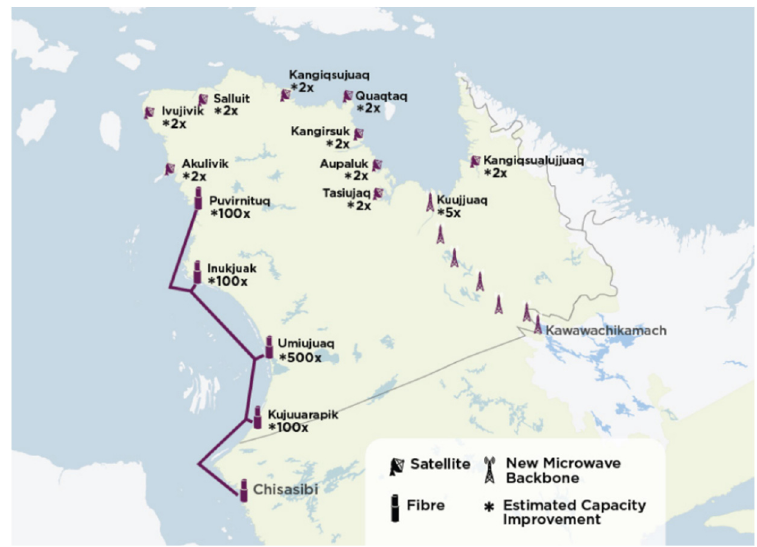
Figure 3. Telecommunication network in the Nanavut.